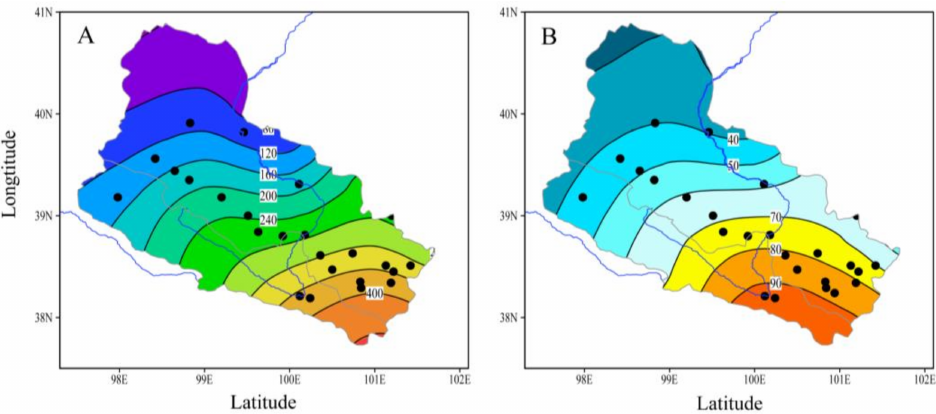
Figure 2. Spatial distribution of total annual precipitation amount (( A ); unit: mm) and number of days with precipitation (NDP) (( B ); unit: day) in the HRB from 1984 to 2014 (black dots represent meteorological stations).